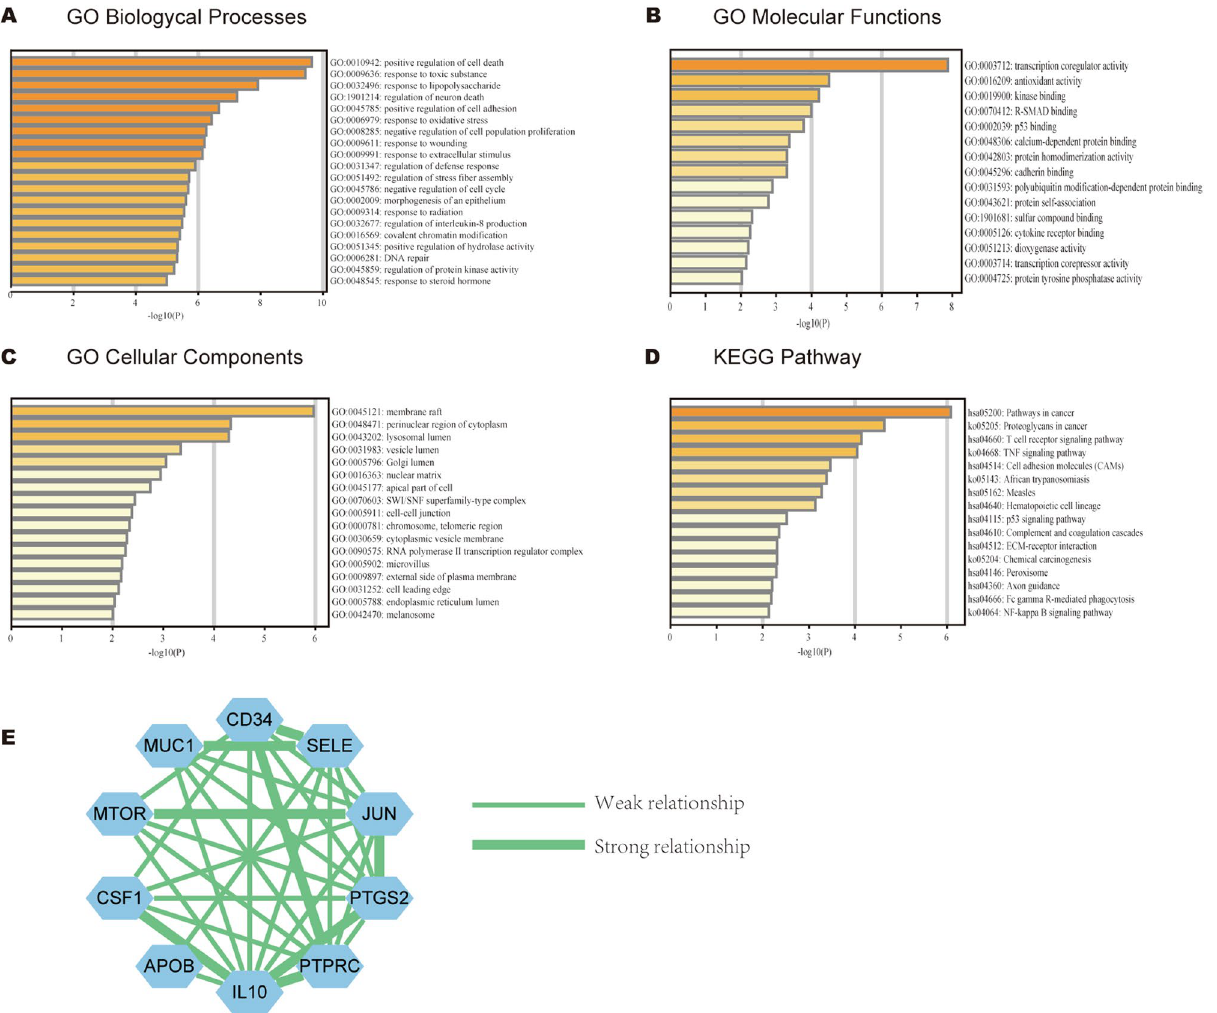
Figure 2. GO, KEGG and PPI network. ( A – C ) GO enrichment analysis with common genes, ( D ) KEGG pathway analysis with common genes, ( E ) PPI network of hub genes.